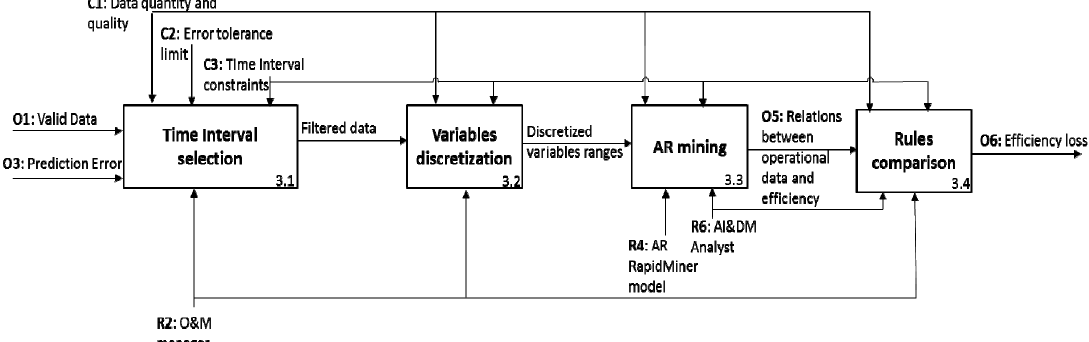
Figure 8. Level-2 representation of the Association Rule (AR) mining step.